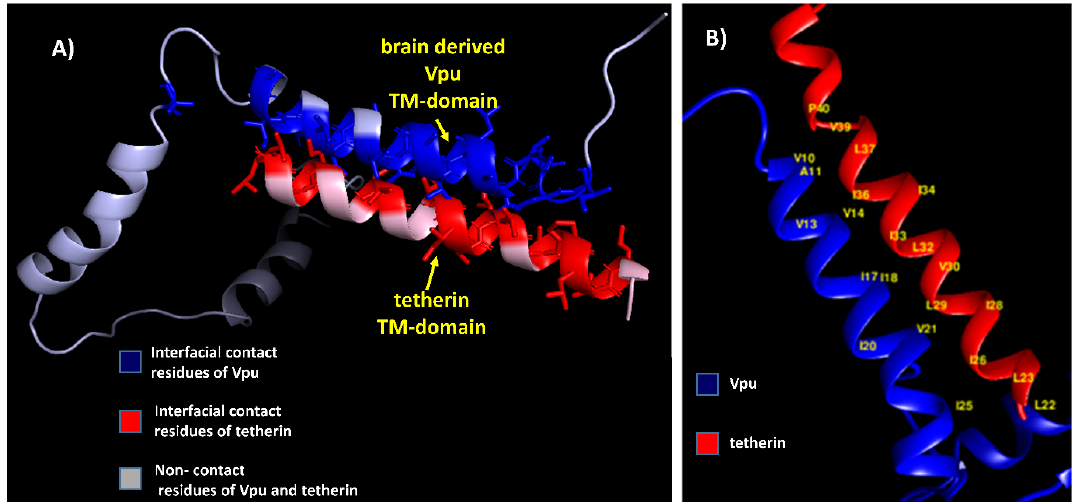
Figure 4. ( A ) Brain-derived Vpu–tetherin complex with interfacial contact residues of Vpu in blue, interfacial residues of tetherin in red, and non-contact residues in grey. ( B ) Residues forming hydrophobic interactions (labeled in yellow) between brain-derived Vpu and tetherin.